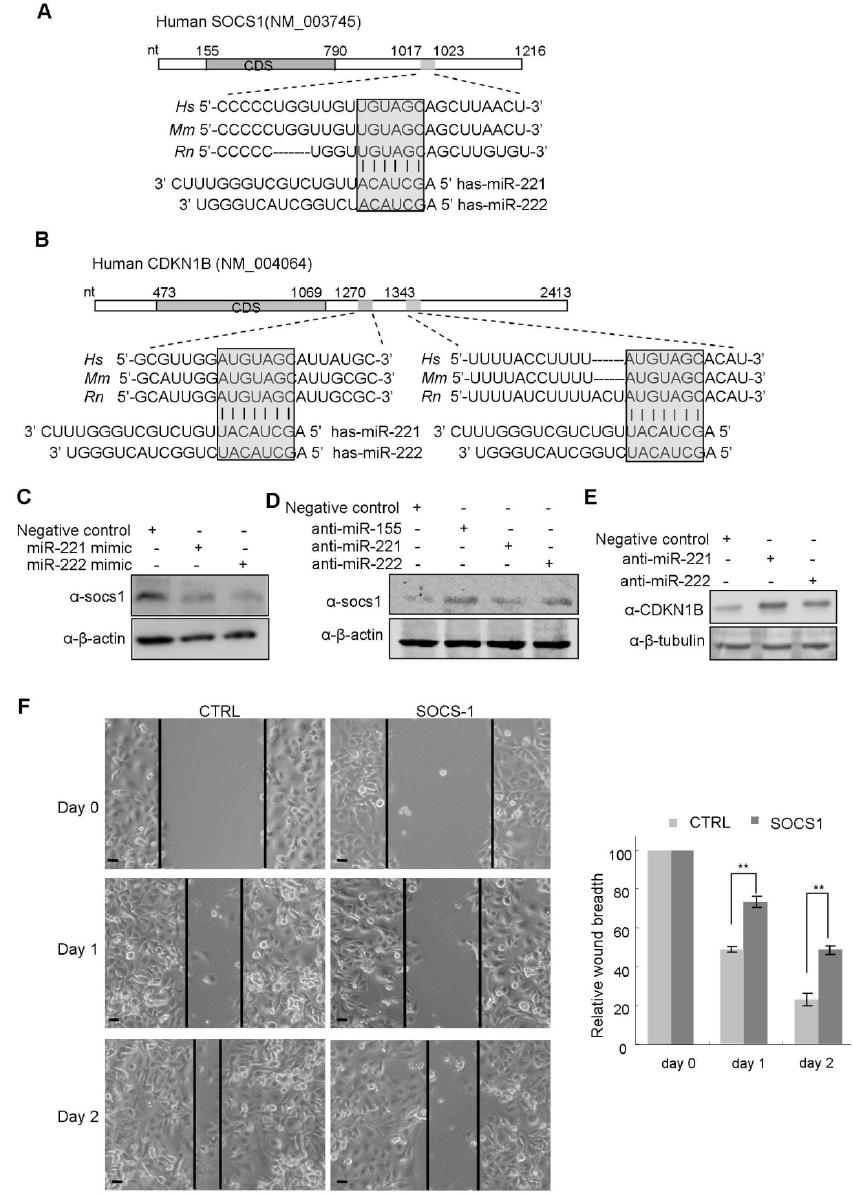
Figure 6. miR-221 and miR-222 suppressed expression of SOCS1 and CDKN1B. ( A ) Schematic representation of the Human SOCS1 3' UTR showing the highly conserved miR-221/222 binding site (highlighted and boxed) between species. The “seed” sequence of miR-221/222 (nt 2–7) is complementary to the SOCS1 3' UTR. ( B ) Sequence analysis of the 3' UTR of CDKN1B mRNA identified two conserved binding sites to the “seed” sequence of miR-221 and miR-222. ( C ) Western blot analysis indicating the inhibition of SOCS1 expression by miR-221/222 overexpression in MCF-7 cells. β -actin served as loading control. ( D ) Western blot analysis indicating the up-regulation of SOCS1 by miR-221/222 inhibitors in MDA-MB-231 cells. miR-155 was used as positive control for targeting SOCS1. β -actin served as loading control. ( E ) Western blot analysis demonstrating the up-regulation of CDKN1B by miR-221/222 inhibitors in MDA-MB-231 cells. β -tubulin served as loading control. ( F ) SOCS1 overexpression in MDA-MB-231 cells suppressed cellular migration. Data are mean ± SEM ( n = 3). ** p <